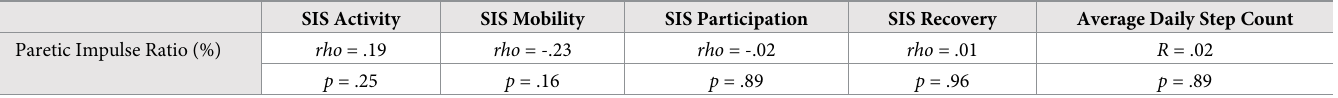
Table 2. Partial correlation of propulsion with quality-of-life (Spearman’s Rho , N = 40) and participation (Pearson’s R , N = 38) measures, controlling for comfort- able gait speed. SIS Activity SIS Mobility SIS Participation SIS Recovery